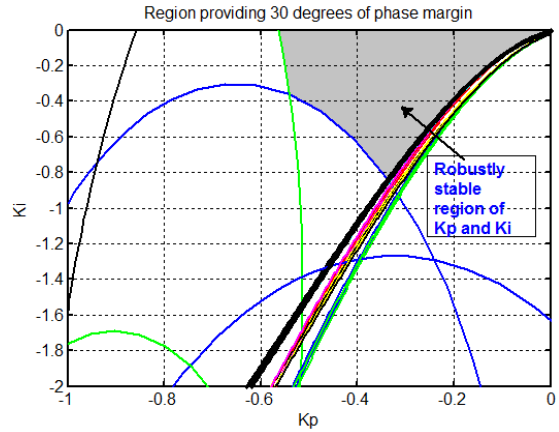
Figure 8. The intersection of all the 16 - Kharitonov plants provides the region of robust stability with atleast 30 0 phase marin. Magnified view of Figure